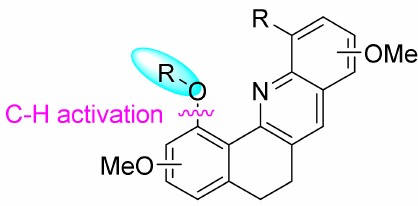
Figure 2. Polysubstituted 5,6-dihydrobenzo[ c ]acridines via C-H bond